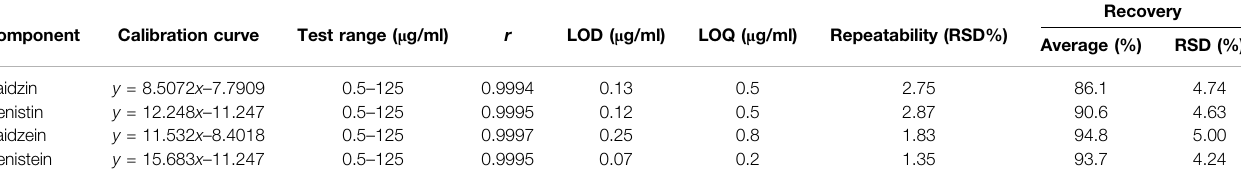
TABLE 1 | Linearity, LOD, LOQ, repeatability and recovery.